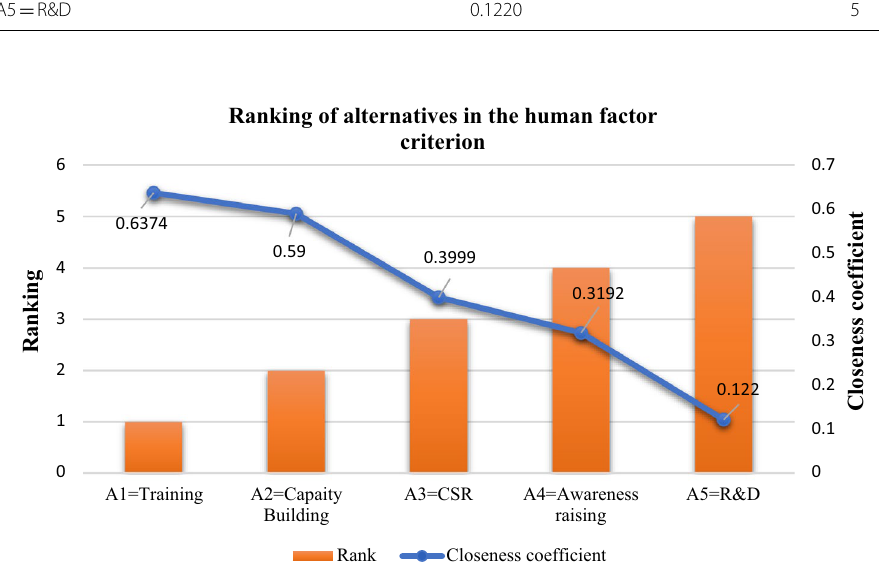
Fig. 10 Ranking of alternatives in the human factor